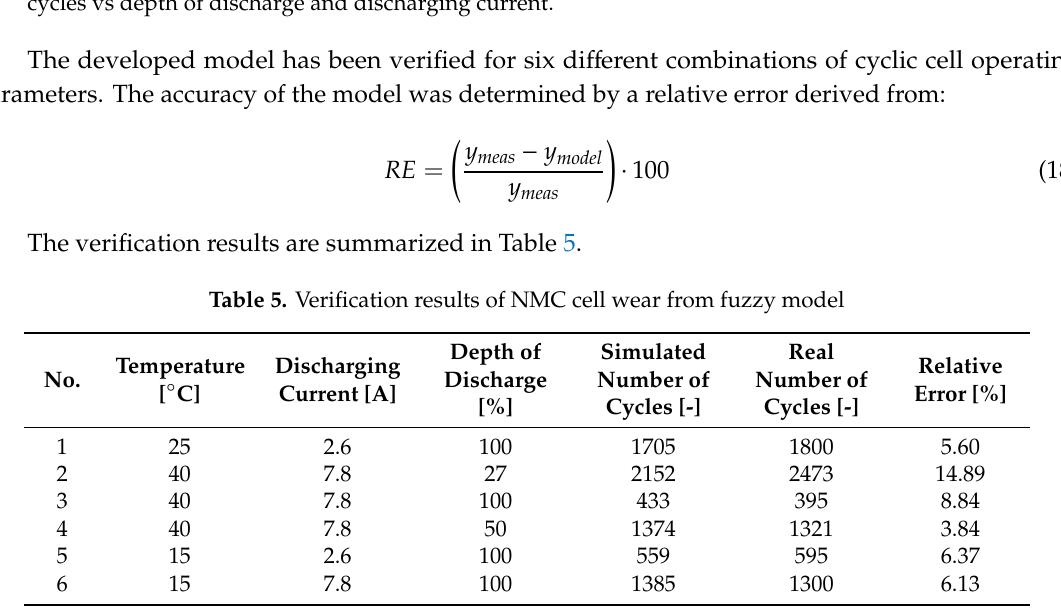
Figure 7. Illustration of the inference process of the model: ( a ) number of cycles vs depth of discharge and temperature, ( b ) number of cycles vs discharging current and temperature, and ( c ) number of cycles vs depth of discharge and discharging current.